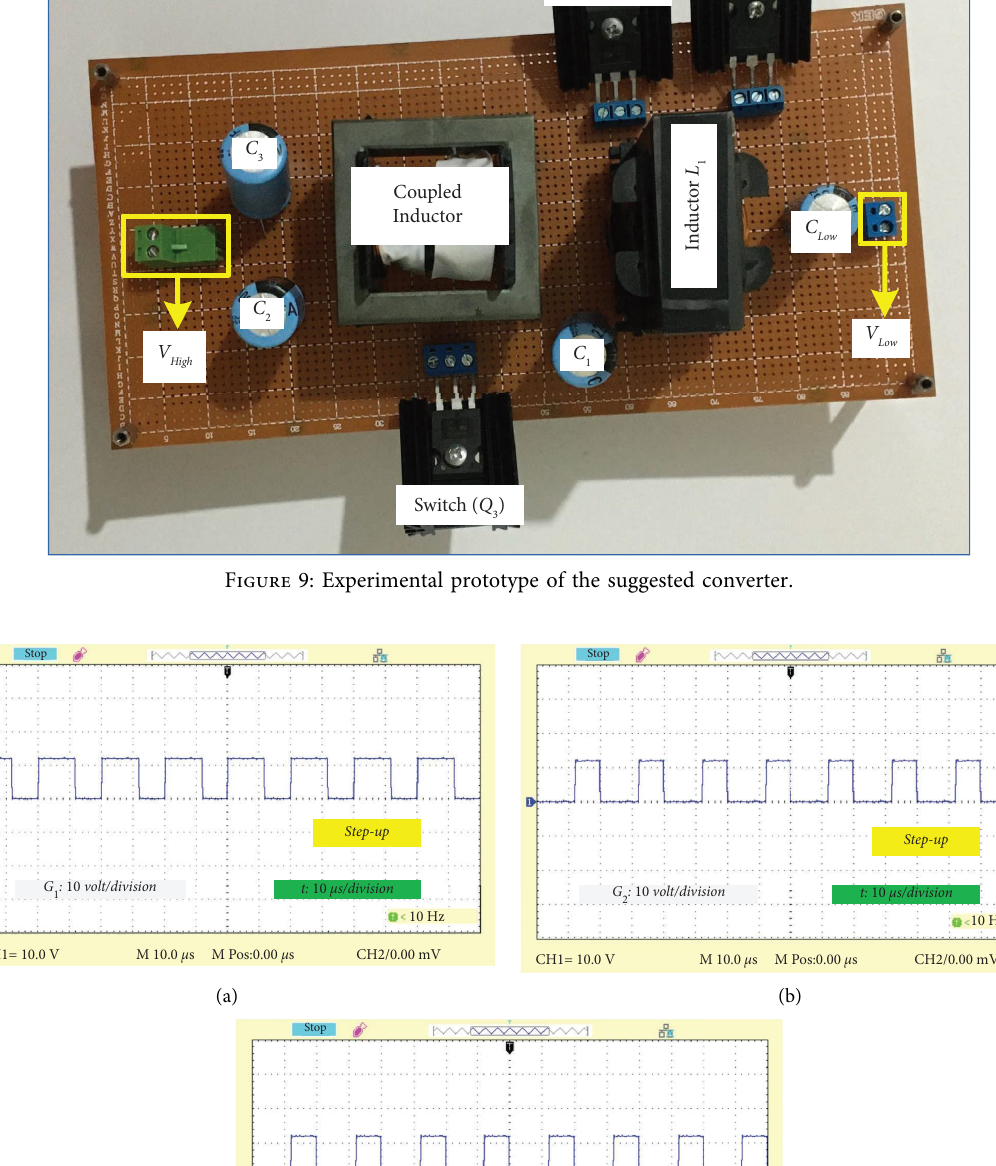
G 1 , (b) V G 2 , and (c) V G 3